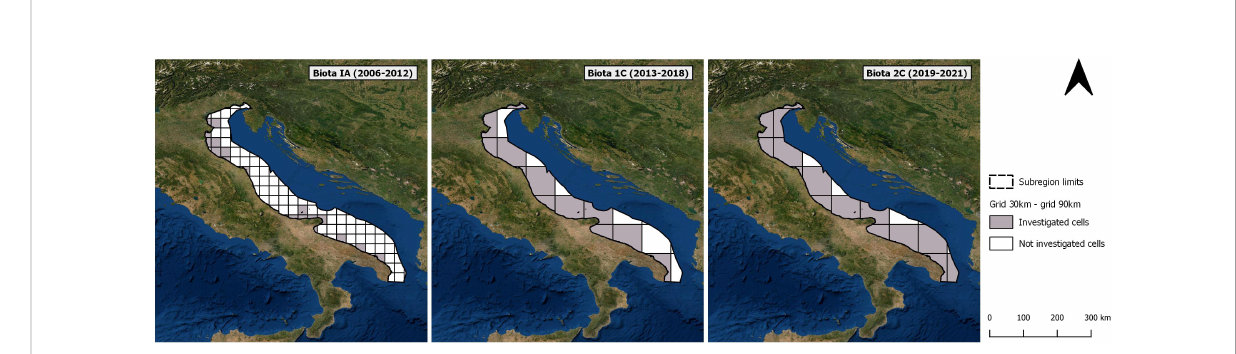
FIGURE 7 Coverage of biota sampling in the Adriatic Sea in the three phases of MSFD (Initial Assessment 2006 – 2012, First Cycle 2013 – 2018, and Second Cycle 2019 –